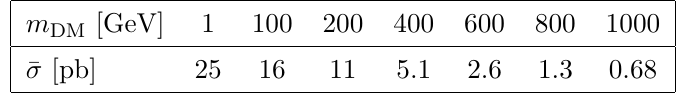
Table 1 . Total DM pair-production cross-section, for M (cid:3) = 1 TeV at the 13 TeV